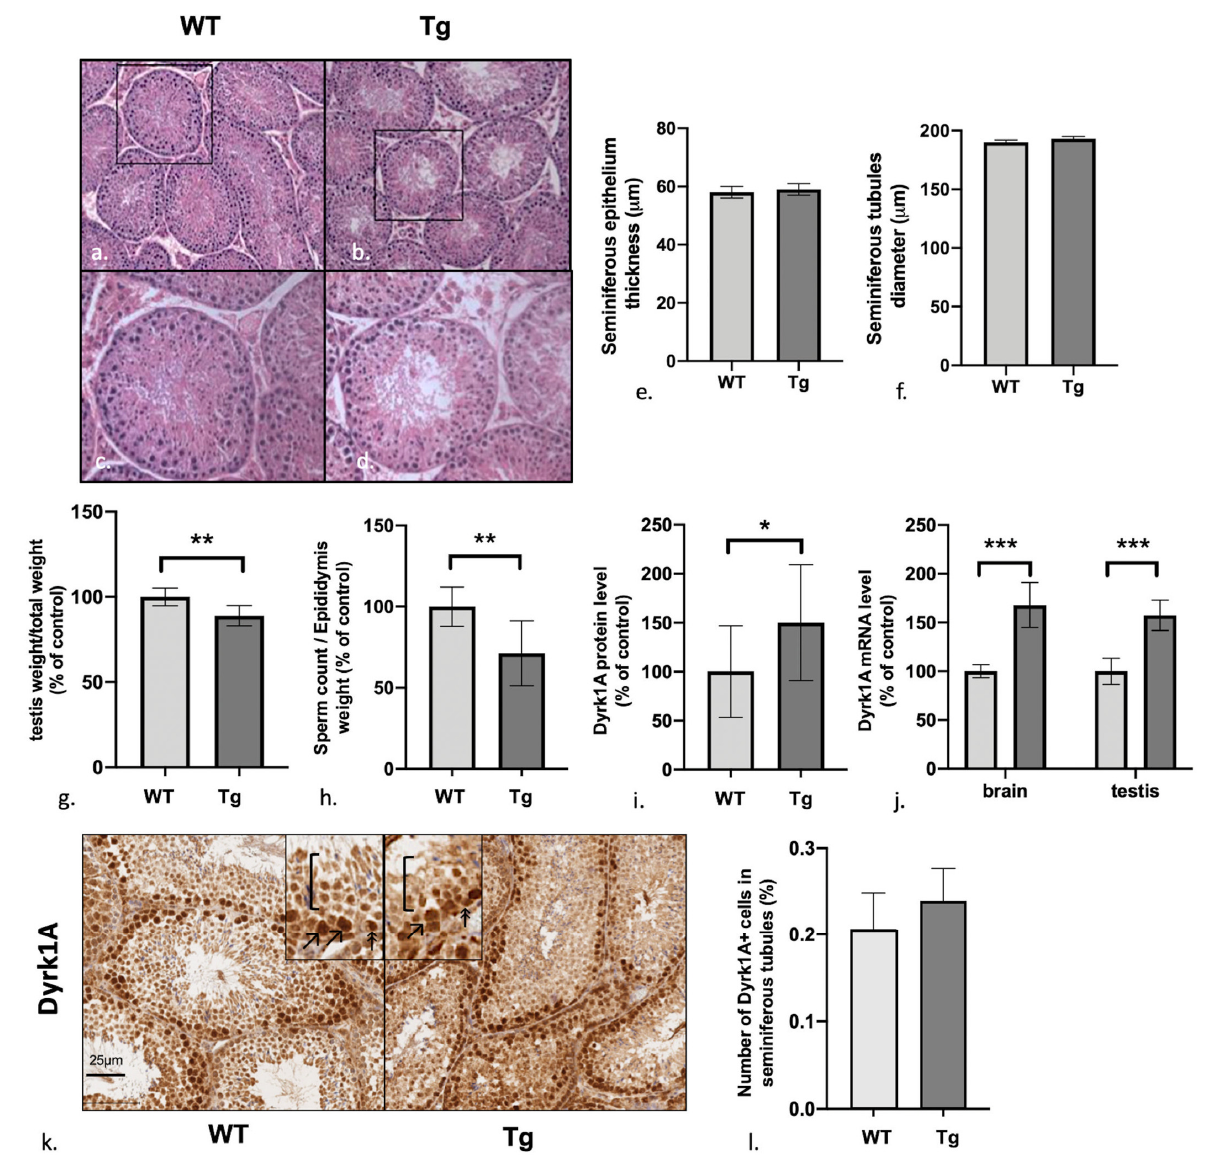
Figure 1. Experiments in Tg mice and WT controls. Standard histology of testis ( a – d ) shows no difference in number, size, and cellular compound of seminiferous tubules between Tg mice and control. Diameter ( e ), and thickness ( f ) of 100 seminiferous tubules per mouse were measured: histograms show mean and standard deviation, no significant difference was found; ( g ) testis weight; ( h ) sperm count; ( i , j ) protein and mRNA levels of Dyrk1A in testis and brain; ( k , f , l ) IHC assay for Dyrk1A in the testis of Tg mice and WT controls. The two groups of mice did not differ in the number and intensity of Dyrk1a+ cells in seminiferous tubules. In control mice, Dyrk1a was expressed by cells close to the basal membrane, corresponding to the early stages of spermatogenesis and as show in the cropped images: double arrowheads: small cells close to the basal membrane, corresponding to spermatogonia; single arrowheads: large cells not in contact with the basal membrane, corresponding to primary spermatocytes; square brackets: later stages of spermatogenesis, with a lower Dyrk1a intensity. p value : 0.033 (*), 0.002 (**), <0.001 (***). 3.2. Dyrk1A (over)Expression in Tg Mice Is Predominantly Observed in the Early Stages of Spermatogenesis Real-time quantitative RT-PCR analysis of Dyrk1A mRNA and Western blotting of Dyrk1A protein confirmed that Dyrk1A was overexpressed in Tg mice by a factor of 1.5 vs. WT in the testis (Figure 1i: mean ± SD in a Western blot: 150 ± 59% of the WT value; p = 0.019, n = 12 WT/16 Tg; Figure 1j: mean ± SD in an RT-PCR: 157.9 ± 58.9% of the